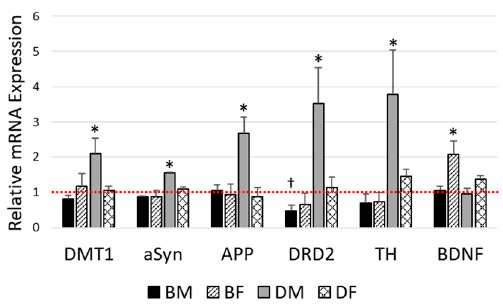
Figure 4. Diet-induced obesity impact on olfactory bulb gene expression. Fold change comparisons by diet for these genes are shown for the olfactory bulb. The low-fat diet (LFD) mRNA expression was established as the control (LFD reference = 1 as indicated by the horizontal dashed bar). Fold change compared with each control was determined using the comparative Ct method. Data are represented as mean ± SEM. * p < 0.05, † approaching significance ( p = 0.05–0.10). DMT1 = divalent metal transporter 1, aSyn = alpha-synuclein, APP = amyloid precursor protein, DRD2 = dopamine transporter D2, TH = tyrosine hydroxylase, BDNF = brain-derived neurotrophic factor, BM = C57BL/6J males, BF = C57BL/6J females, DM = DBA/2J males, DF = DBA/2J females.